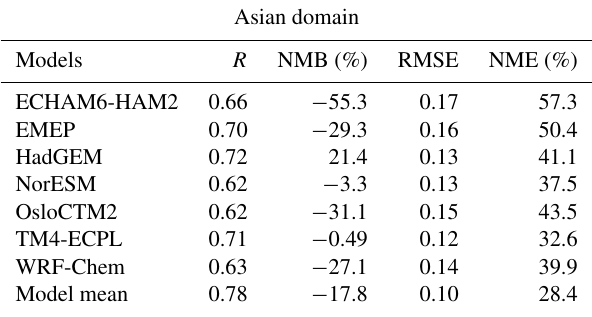
Table 7. Correlation coefficient R , normalized mean bias NMB, root mean square error RMSE and normalized mean error NME, based on spatial variations calculated from monthly mean differ- ences between MODIS and simulated AODs over the Asian do- main (defined here as the entire domain minus eastern China and northern India) for August and September